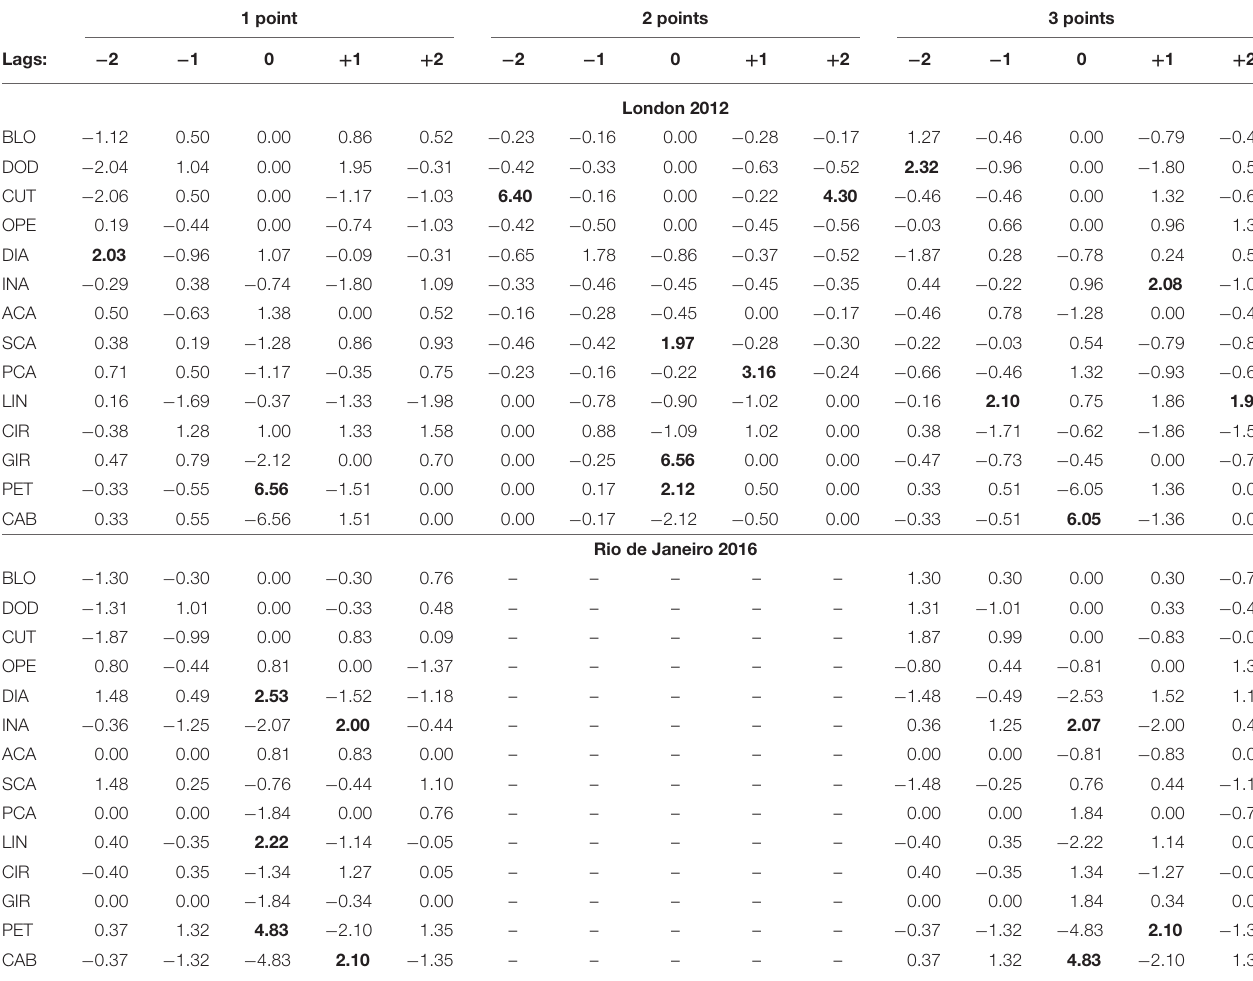
TABLE 4 | Lag sequential analysis of 2012 and 2016 Olympic